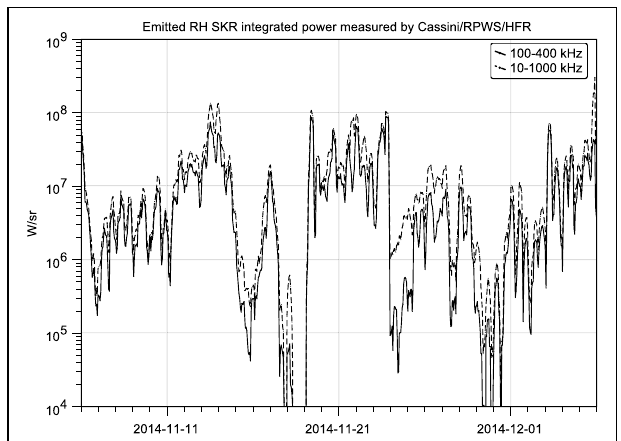
FIGURE 5 | Right Handed polarized emitted SKR power integrated on 100–400 kHz (plain line) and 10–1000 kHz (dashed line), as measured by Cassini/RPWS/HFR. The data has been averaged over 15 min.